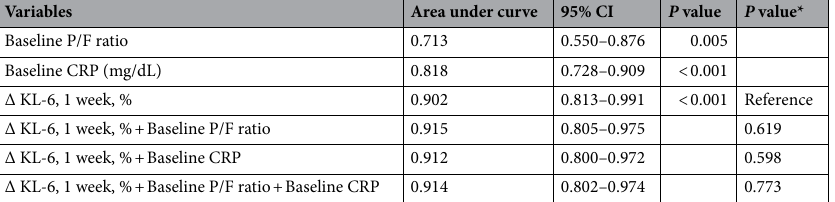
Table 5. Comparison of the performance of the risk prediction models for in-hospital mortality of patients with AE-ILD. * P value compared with the risk prediction model of Δ KL-6 (1 week, %). AE-ILD acute exacerbation of interstitial lung disease, Δ changes from baseline, KL-6 Krebs von den Lungen-6, P/F ratio ratio of partial pressure of oxygen to the fraction of inspiratory oxygen, CRP C-reactive